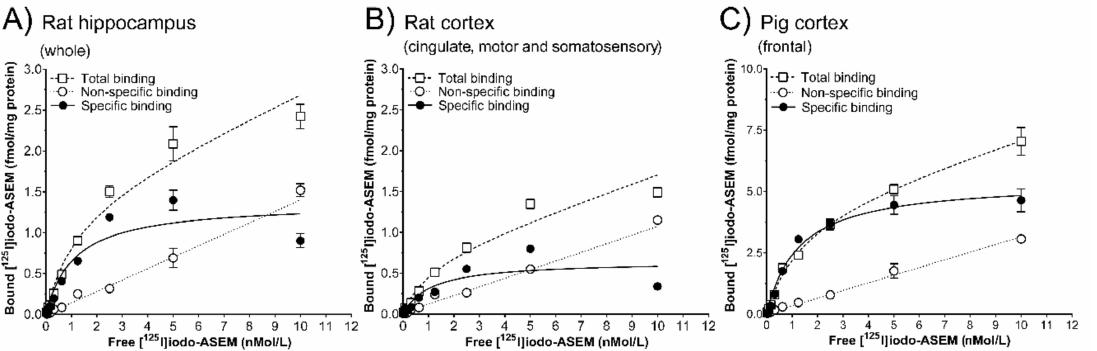
Figure 3. Saturation binding of [ 125 I]Iodo-ASEM (0.02-10 nMol / L) to 12 µ m sections from the rat hippocampus and cortex ( A , B , n = 1) and pig frontal cortex ( C , n = 1) brain. Non-specific binding was determined in the presence of 10 µ Mol / L SSR-180,711. Optical density of the autoradiograms was converted into ligand binding (fmol / mg protein ± S.E.M.) from a representative experiment. Data from saturation binding experiments were analysed by non-linear regression. Individual K d and B max values are indicated in Section 2.1. All autoradiographic experiments and quantifications are carried out in 2–4 sections per animal using 10 radioligand